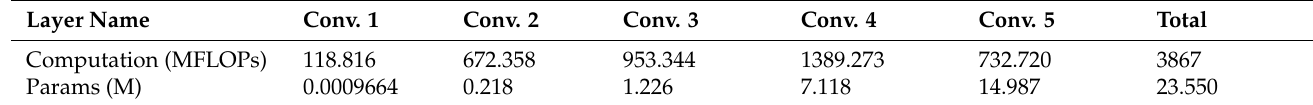
Table 8. Computation and parameters of